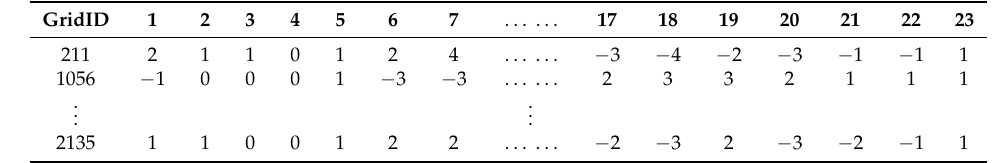
Table 3. Examples of the